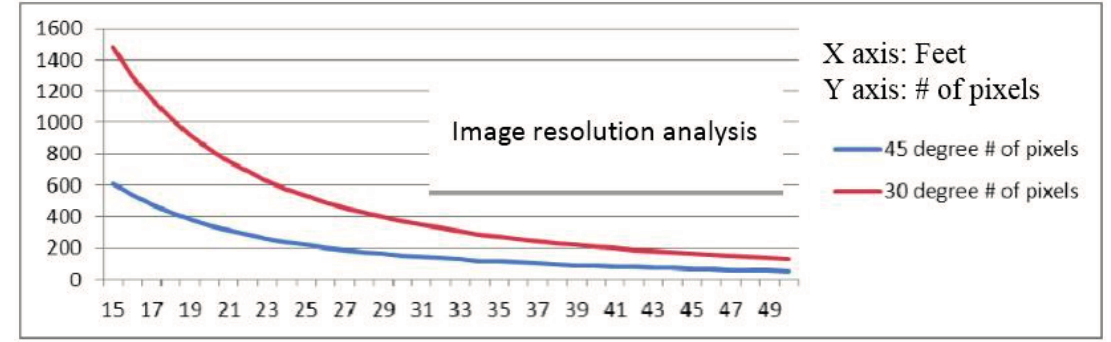
Figure 2. Range vs. resolution analysis, Number of pixels that will be illuminated on a 27-inch (68.58 cm) diameter object from 15 feet (4.57 m) to 50 feet (15.24